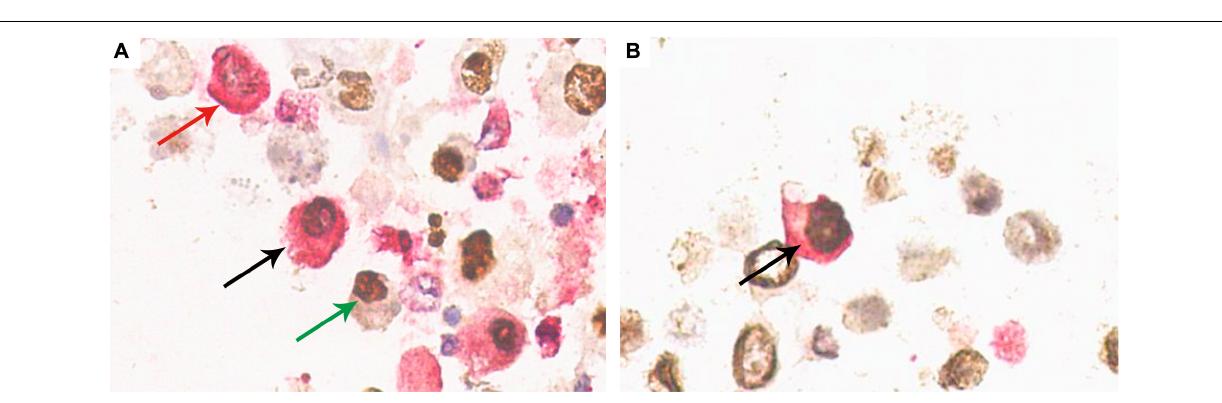
FIGURE 3 | Representative pictures of double-immunostaining with SV40-T/HGD (A) or SV40-T/58K (B) in the same area from renal allograft with BKPyV infection. The infected proximal tubular epithelial cells expressed HGD/SV40-T ( A , × 100) and 58K/SV40-T ( B , × 100). Black triangles referred to the same proximal tubules infected by BKPyV in consecutive sections. The infected distal tubular epithelial cells expressed HGD/SV40-T ( A , × 100) and SV40-T but not 58K ( B , × 100). Blue circles referred to the same distal tubules infected by BKPyV in consecutive sections. 58-kDa Golgi protein (58K); homogentisate 1, 2-dioxygenase (HGD).